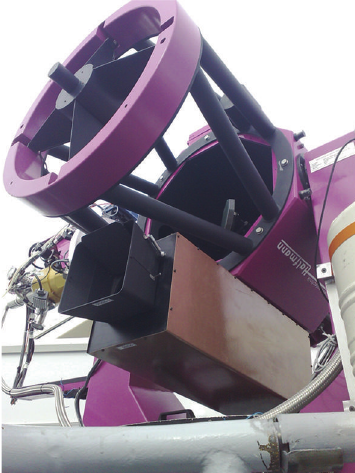
Figure 1: The REM Observatory: one dome, two telescopes, three instruments . Under the main telescope body is the Tortora telescope with its wide field, fast photometer. On the left Nasmyth focus the are the visible (ROSS) and infrared (REMIR) cameras, partially hidden in the